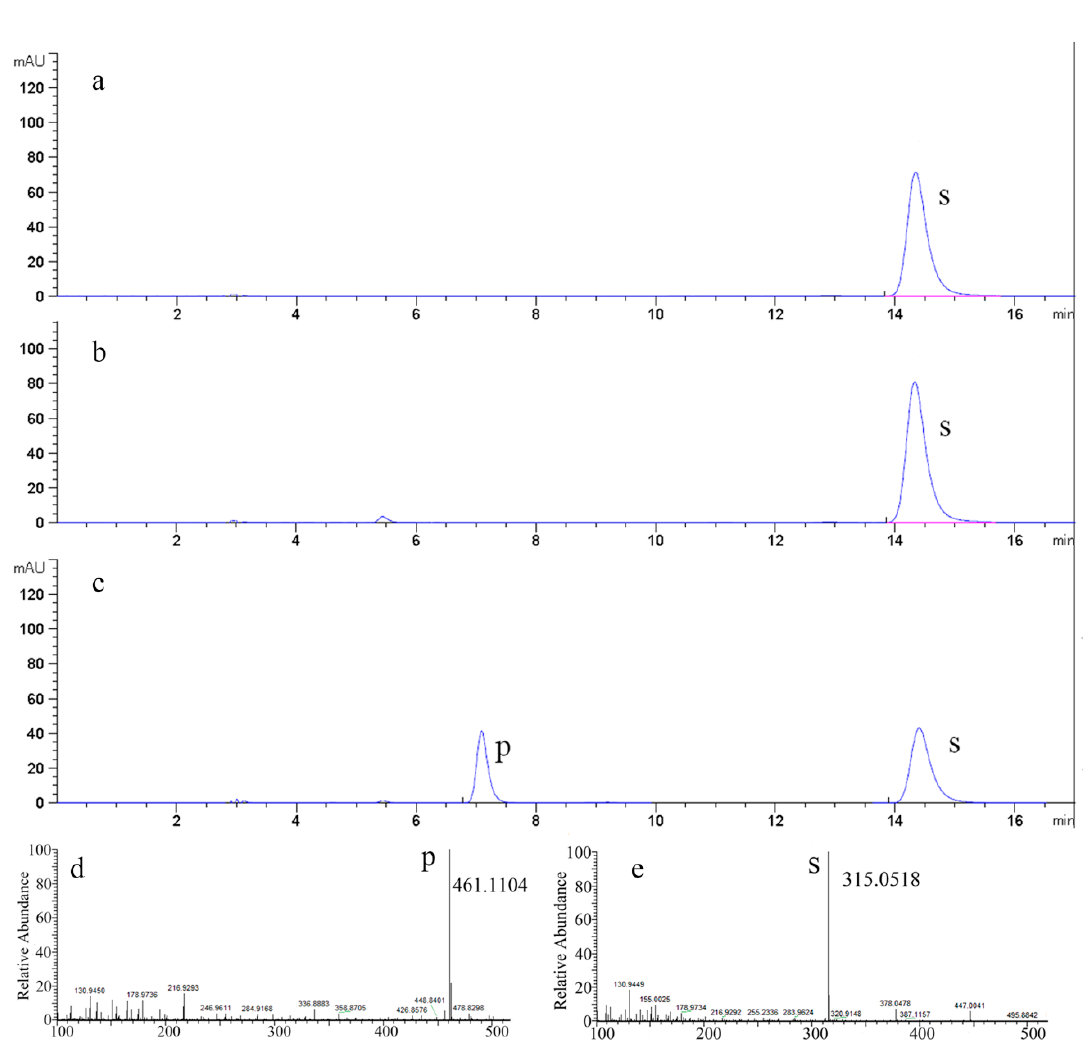
Figure 5. HPLC and LC / MS analysis of products synthesized from isorhamnetin. ( a ) HPLC analysis of the reaction system with 78D1 only. ( b ) HPLC analysis of the reaction system with 78D1 and GmSUS. ( c ) HPLC analysis of the reaction system with 78D1, GmSUS, and VvRHM. ( d , e ) LC / MS analysis of the product of the synergistic catalysis. Table 1. E ff ect of Enzyme Concentration on Product Yields of Isorhamnetin-3- O -rhamnoside